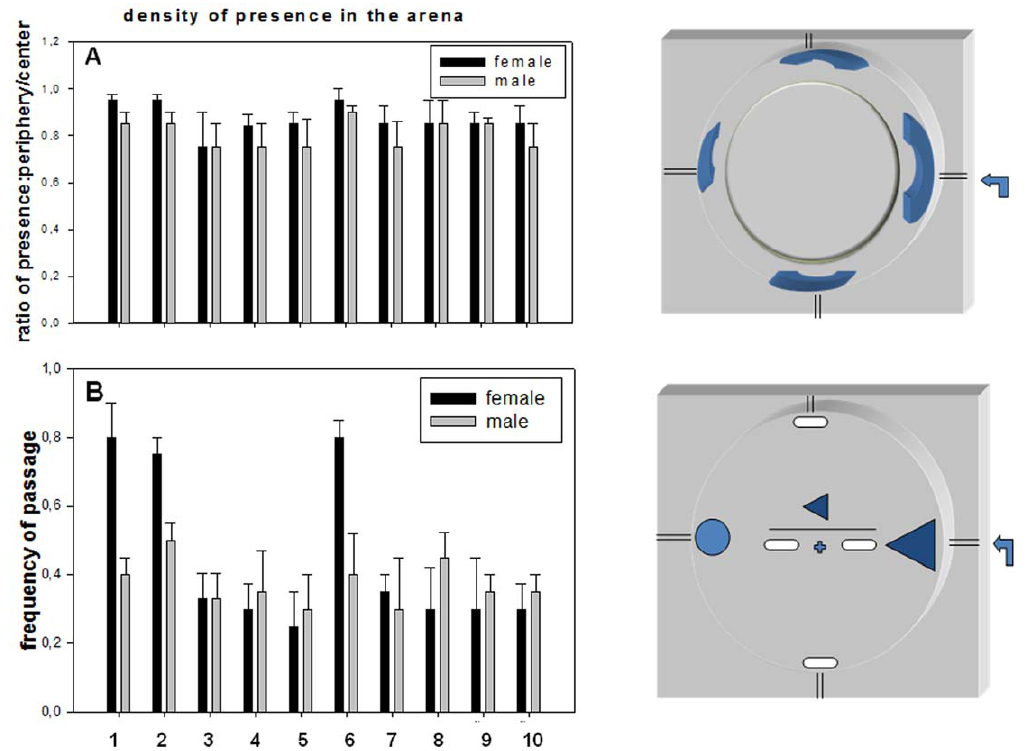
Figure 3. Comparative propionaldehyde-induced behavioral response between strains. Ten five days old female (black) and male (grey) flies were tested after two hours of starvation for propionaldehyde-induced exploration using the arena/air pusher system. This series of experiments was conducted during the odor gradient phase generated in the arena prior to reaching a uniform concentration (equal concentration between syringe and arena). Flies were tested for ten minutes, during which time they were active. (A) The ratio of time spent in the periphery versus the inside circle is indicated in the graph for the strains tested (1 corresponds to the entire time spent in the arena). (B) In another series of experiments, the passages in front of the two white oblong shapes and of the triangle were counted. The graph represents the ratio of passages in the triangle to the total (1= triangle plus the two white oblong shapes). Bars represent the mean + / 2 S.E. for ten flies (females or males). 1, for R ; 2, for S ; 3, Aldh-III* ; 4 , CG11699 * (Szeged stock P-element insertion in CG11699 ); 5, CG11699** , [ (EP)EP Berkeley project, P-element insertion in CG11699 )]; 6, CS , Canton S ; 7, CG11699** ; for S ; 8, CG11699**; for R ; 9, CG11699 *; for S and 10, CG11699 *; for R . Mainly, the ratio of passages in the odor entry landmark (triangle) gave, respectively for females and males: for R , 0.8 + / 2 0.1 and 0.4 + / 2 0.05; for S , 0.75 + / 2 0.05 and 0.5 + / 2 0.05; Aldh-III* , 0.35 + / 2 0.05 for both females and males; CG11699* , 0.3 + / 2 0.05 and 0.38 + / 2 0.1; CG11699* ; for R , 0.3 + / 2 0.15 and 0.35 + / 2 0.1; CG11699 *; for S , 0.3 + / 2 0.1 and 0.35 + / 2 0.1. Statistical analysis was performed with a Paired t -test on ten individuals for each strain and is reported in table